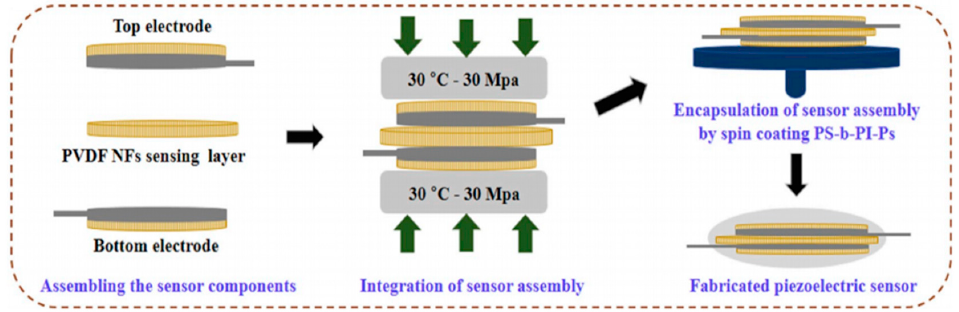
Figure 19. Schematic associated with the preparation of PVDF nanofibers (NFs), PVDF NFs-AgNPs electrodes and fabrication of piezoelectric sensor. Reprinted with permission from [134].